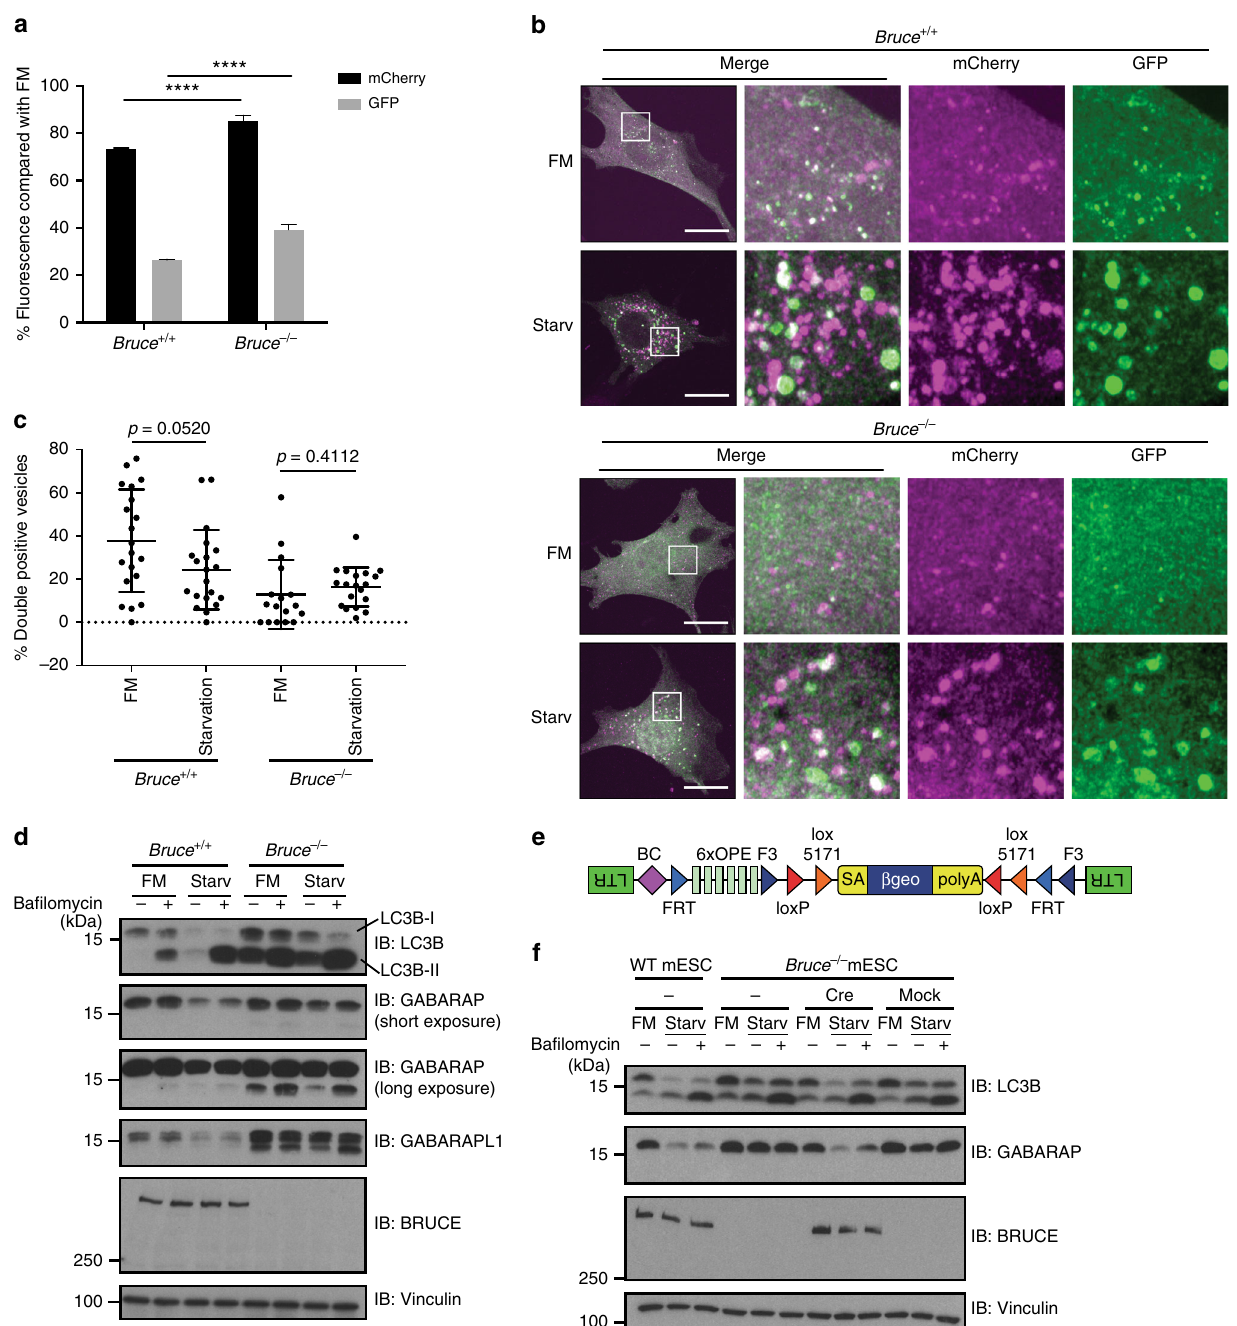
Fig. 2 BRUCE is required for starvation-induced degradation of ATG8 family proteins. a Normalized mCherry and GFP signals after starvation compared to basal condition (FM) analyzed by fl ow cytometry in Bruce + / + and Bruce − / − MEFs stably expressing mCherry-EGFP-LC3B. Data are presented as mean ± SD from three biological replicates (**** p < 0.0001). Representative data are shown from four independent experiments. b Confocal microscopy images of Bruce + / + and Bruce − / − MEFs stably expressing mCherry-EGFP-LC3B in different conditions. FM, fully supplemented medium; Starv, starvation medium for 4 h. Scale bars, 20 µ m. c Quanti fi cation of mCherry-GFP double positive spots in Bruce + / + and Bruce − / − MEFs in regular and starvation conditions (as in b ). Data are presented as dot plots with mean ± SD. n = 20 cells. p -values are indicated and analyzed by t -test. d Protein levels of autophagy markers in Bruce + / + and Bruce − / − MEFs under basal (FM) and 2 h-starved (Starv) conditions with or without Ba fi lomycin A1. e A schematic of the inserted gene trap cassette in Bruce − / − haploid mouse embryonic stem cells (mESCs). f Protein levels of autophagy markers in Bruce + / + and Bruce − / − clone #1 haploid mESCs under basal (FM) and 2 h-starved (Starv) conditions with or without Ba fi lomycin A1. BRUCE expression was recovered by Cre recombinase in Bruce − / − mESCs and compared with mock infected